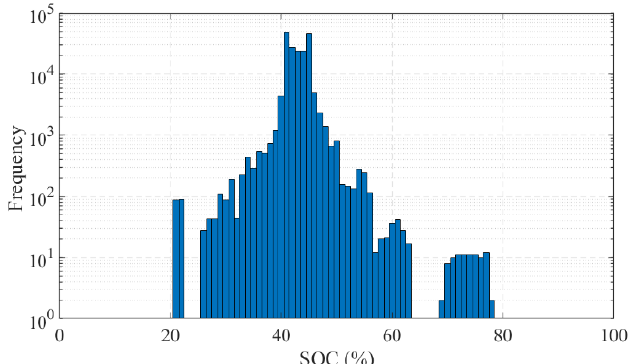
Figure 10. SOC distribution from MSPGA case 2 in Table 6.